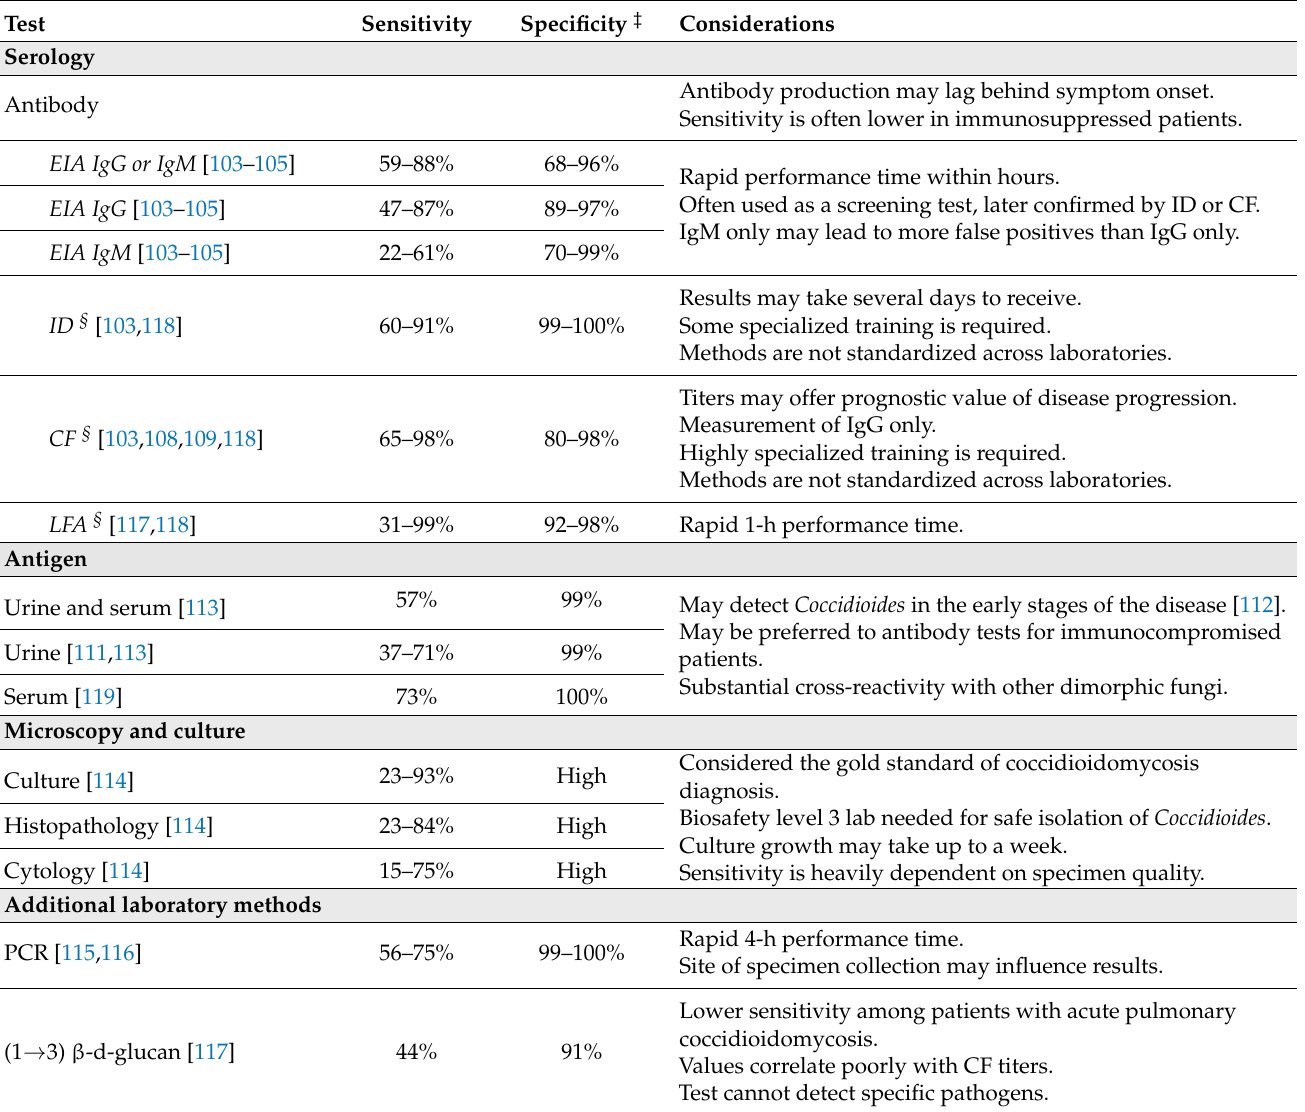
Table 1. Performance and considerations for coccidioidomycosis laboratory diagnostic